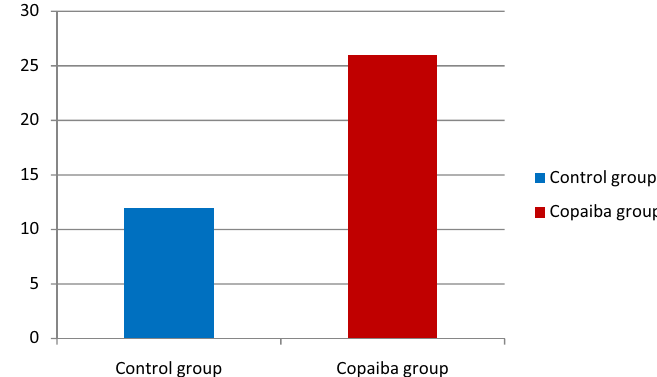
FIGURE 3 – Comparison between weight loss variation in grams between rats of GC and GCop inoculated with Walker 256 carcinoma